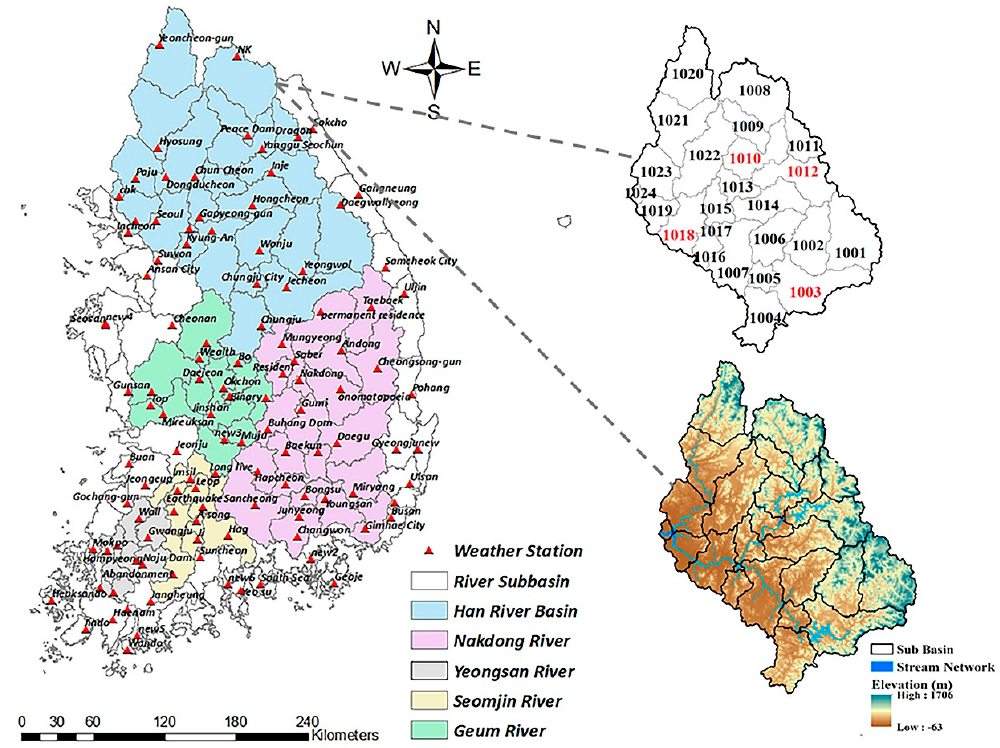
Figure 1. Location of the Han River basin, with the sub-basin ID number, elevation, and stream network. Precipitation and runo ff data of the period 1967 to 2013 were used for investigating the meteorological and hydrological drought characteristics. Precipitation data were obtained from the Korea Meteorological Administration (https: // web.kma.go.kr) for all meteorological stations